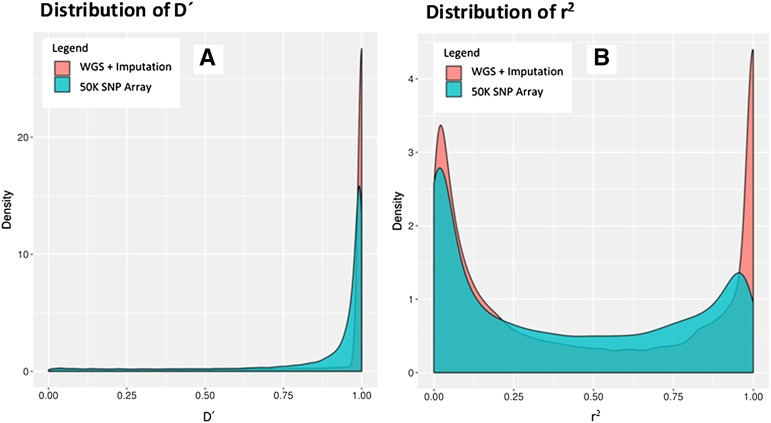
Comparing density plots for LD measures D' (A) and r2 (B) demonstrates that using whole genome sequencing with imputation results in a dataset that has a higher proportion of SNPs is strong pairwise linkage with each other, represented in the heavier tails in red near D' and r2 values of 1.